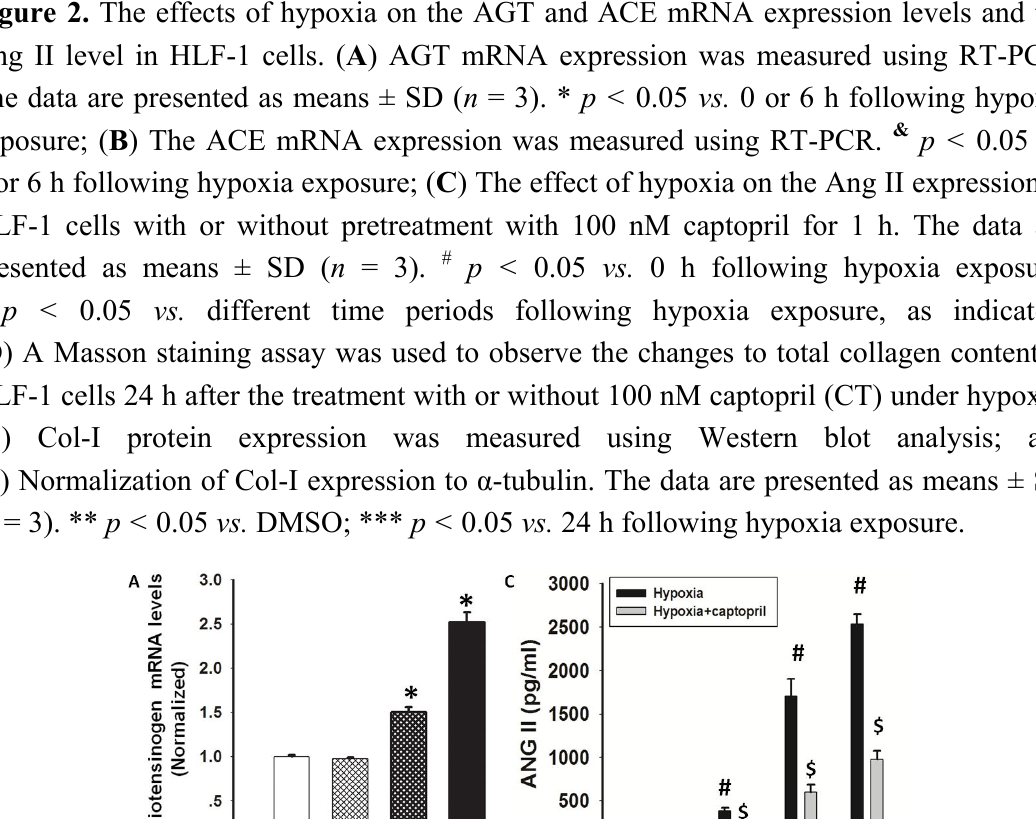
Figure 2. The effects of hypoxia on the AGT and ACE mRNA expression levels and the Ang II level in HLF-1 cells. ( A ) AGT mRNA expression was measured using RT-PCR. The data are presented as means ± SD ( n = 3). * p < 0.05 vs. 0 or 6 h following hypoxia exposure; ( B ) The ACE mRNA expression was measured using RT-PCR. & p < 0.05